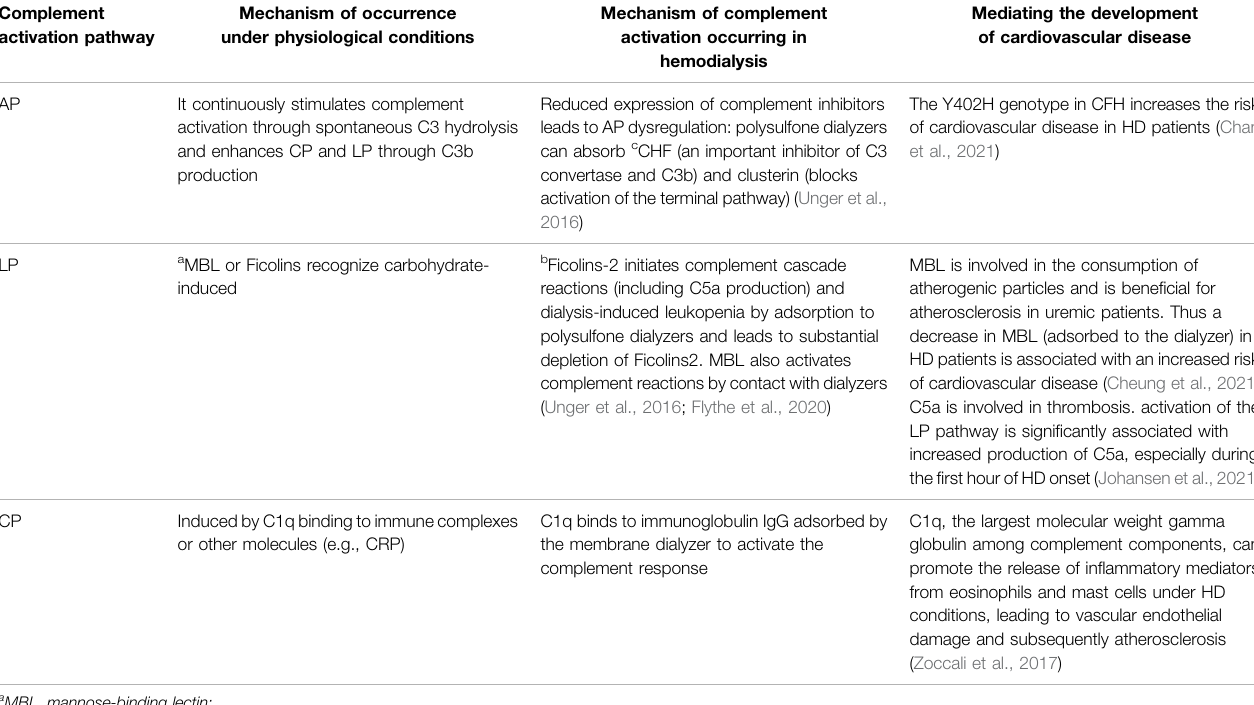
TABLE 1| Complement isactivated bythree pathways: thealternativepathway (AP),the lectin pathway (LP), and theclassicalpathway (CP).Complement activation canbe induced by adsorption of complement components to hemodialysis membranes, with AP and LP being the major activation pathways.AP activity is increased by spontaneous C3 hydrolysis that continuously applies minor stimuli to AP.C3b generated by C3 hydrolysis also enhances CP and LP.Under dialysis conditions, covalent bindingofC3btonucleophilicsurfaces expressedondialyzermembranesandadsorption ofCHFbydialysismembranespromoteactivationofthecomplementsubstitution pathway, and complement factor B acts as an intermediate mediator involved in the continuousoccurrence ofcomplement activation (Flythe et al., 2015).LP isinduced by the binding of MBL or Ficolin to carbohydrates and is activated by the adsorption of large amounts of Ficolin-2 and MBL on dialysis membranes during HD, and a signi fi cant decrease in Ficolin-2 levels can be found in these patients. CP is induced by the binding of C1q to molecules such as immune complexes or CRP and is activated in HD patients mainly by C1q binding to In HD patients, it is mainly activated by C1q binding to circulating